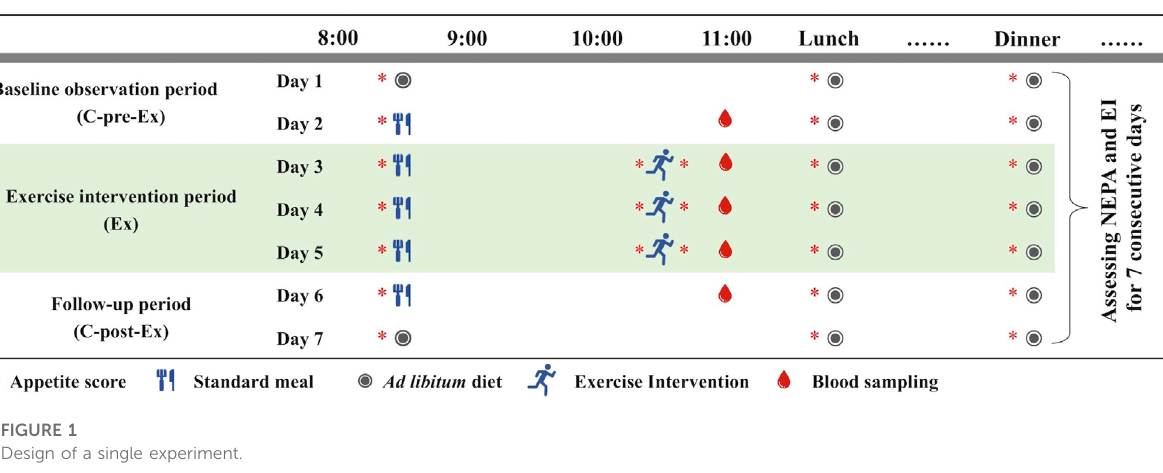
FIGURE 1 Design of a single